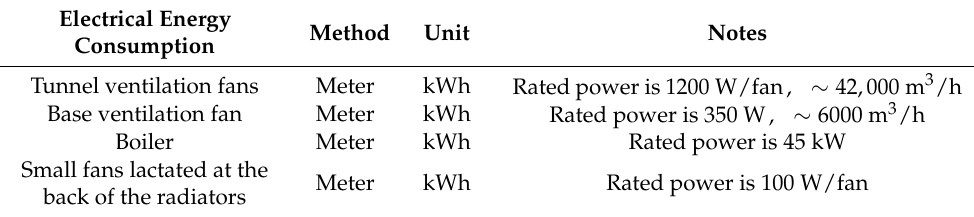
Table 7. Energy consumption monitored in the validation test and applied in the model